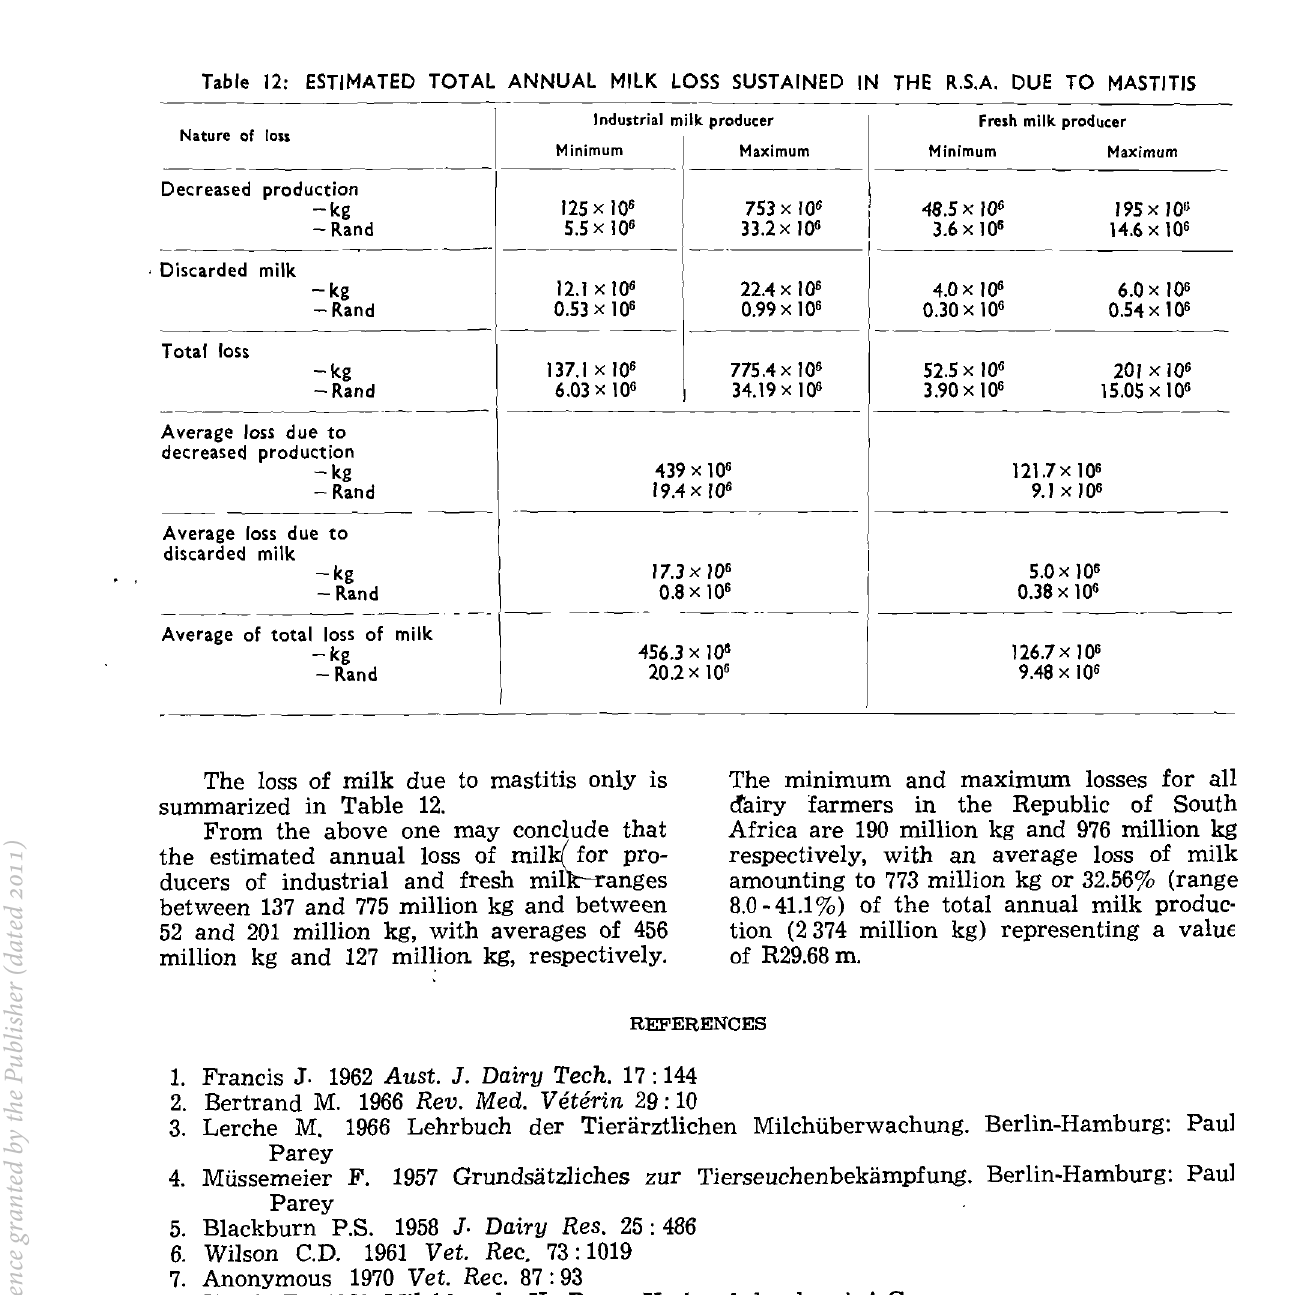
Table 12: ESTIMATED TOTAL ANNUAL MILK LOSS SUSTAINED IN THE R.S.A. DUE TO MASTITIS Nature of